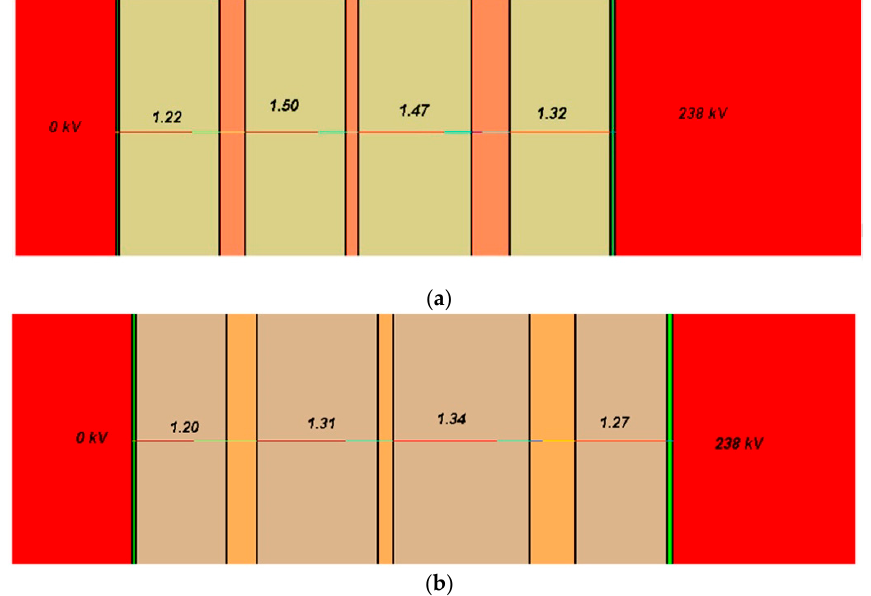
Figure 14. Safety factors windings center: ( a ) ester; ( b ) mineral oil.